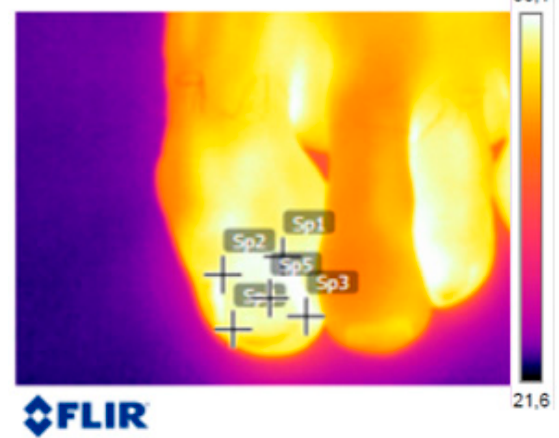
Figure 2. Reference points on the nail.